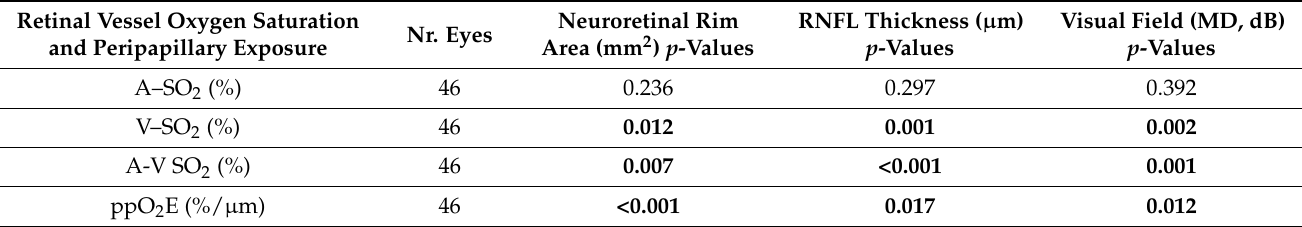
Table 3. Correlations ( p -values) between retinal vessel oxygen saturation and peripapillary oxygen exposure with the extent of glaucomatous damage. p -values < 0.05 are considered statistically significant and are given in bold.